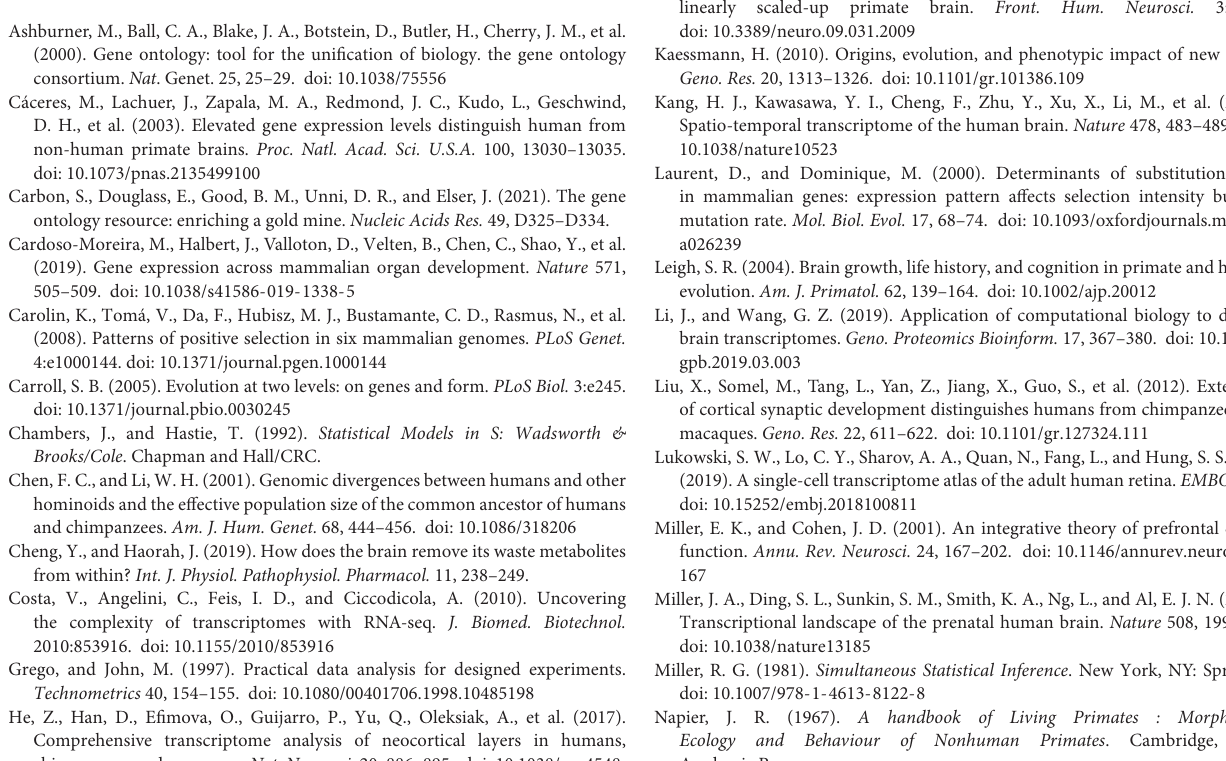
Supplementary Figure 1 | Upset plot of DEGs from the early brain development of macaque and human. Supplementary Figure 2 | Volcano plot of DEGs from the early brain development of macaque and human. Supplementary Figure 3 | Upset plot of organ-related developmental Dges. Supplementary Figure 4 | Kegg pathways of DEGs in different brain regions in rhesus macaques. (A–I) represent top enriched functional categories in the developmental DEGs of Mfc, Dfc, Ofc, Vfc, A1C, S1C, Ipc, Itc, and Stc. Pathway terms were sorted from smallest to largest by p-value . Smaller p-values are indicated by darker red color. The size of the circle represents the number DEGs enriched and the x-axis represents the odd ratio. Supplementary Table 1 | Detailed information of DEGs in 11 brain regions of early developmental peak of rhesus macaques. Supplementary Table 2 | Detailed information of DEGs in six organs of early developmental peak of rhesus